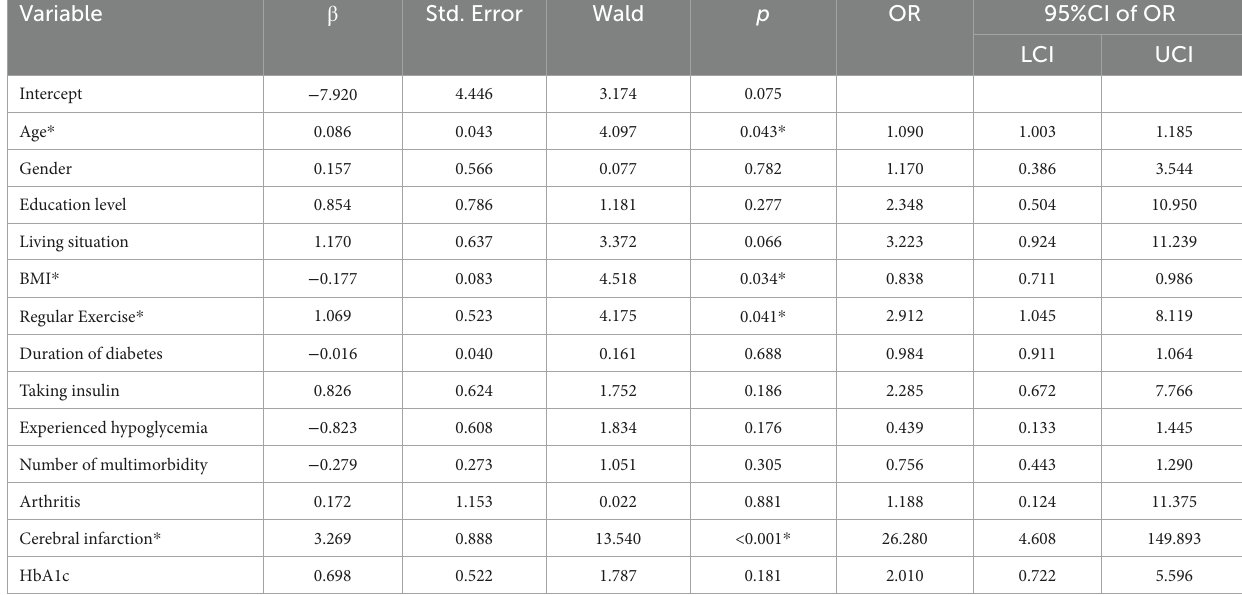
TABLE 5 Multinomial logistic regression analysis of predictors in cluster group membership (‘poor’ vs. ‘good’). Variable